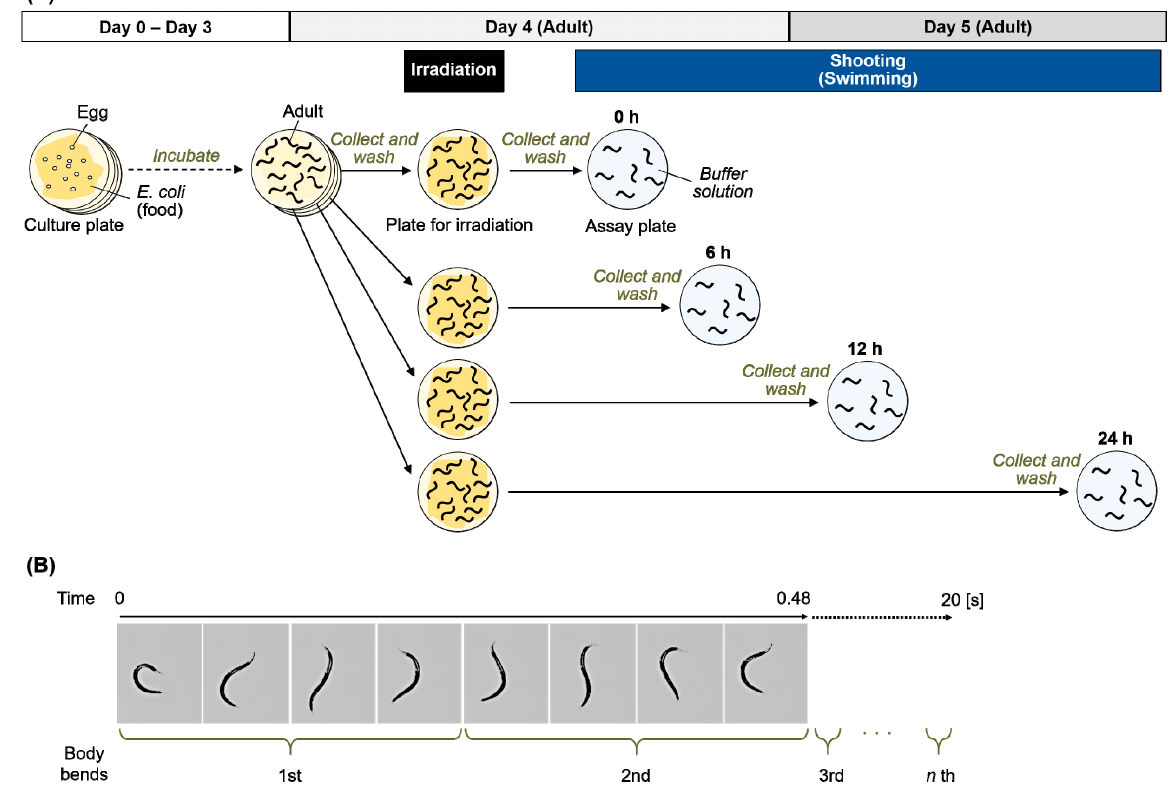
Figure 5. Procedure for swimming assay of C. elegans after whole-body γ -ray irradiation. ( A ) Scheme of this experiment. Well-fed adult worms were irradiated with γ -rays. After irradiation, the worms were incubated for 0, 6, 12, and 24 h, transferred to the NGM plate, and S-basal buffer solution was added. Swimming behavior of worms was video-recorded for at least 20 s. ( B ) The number of head swings of a worm in S-basal buffer solution for 20 s was counted manually based on the movie.